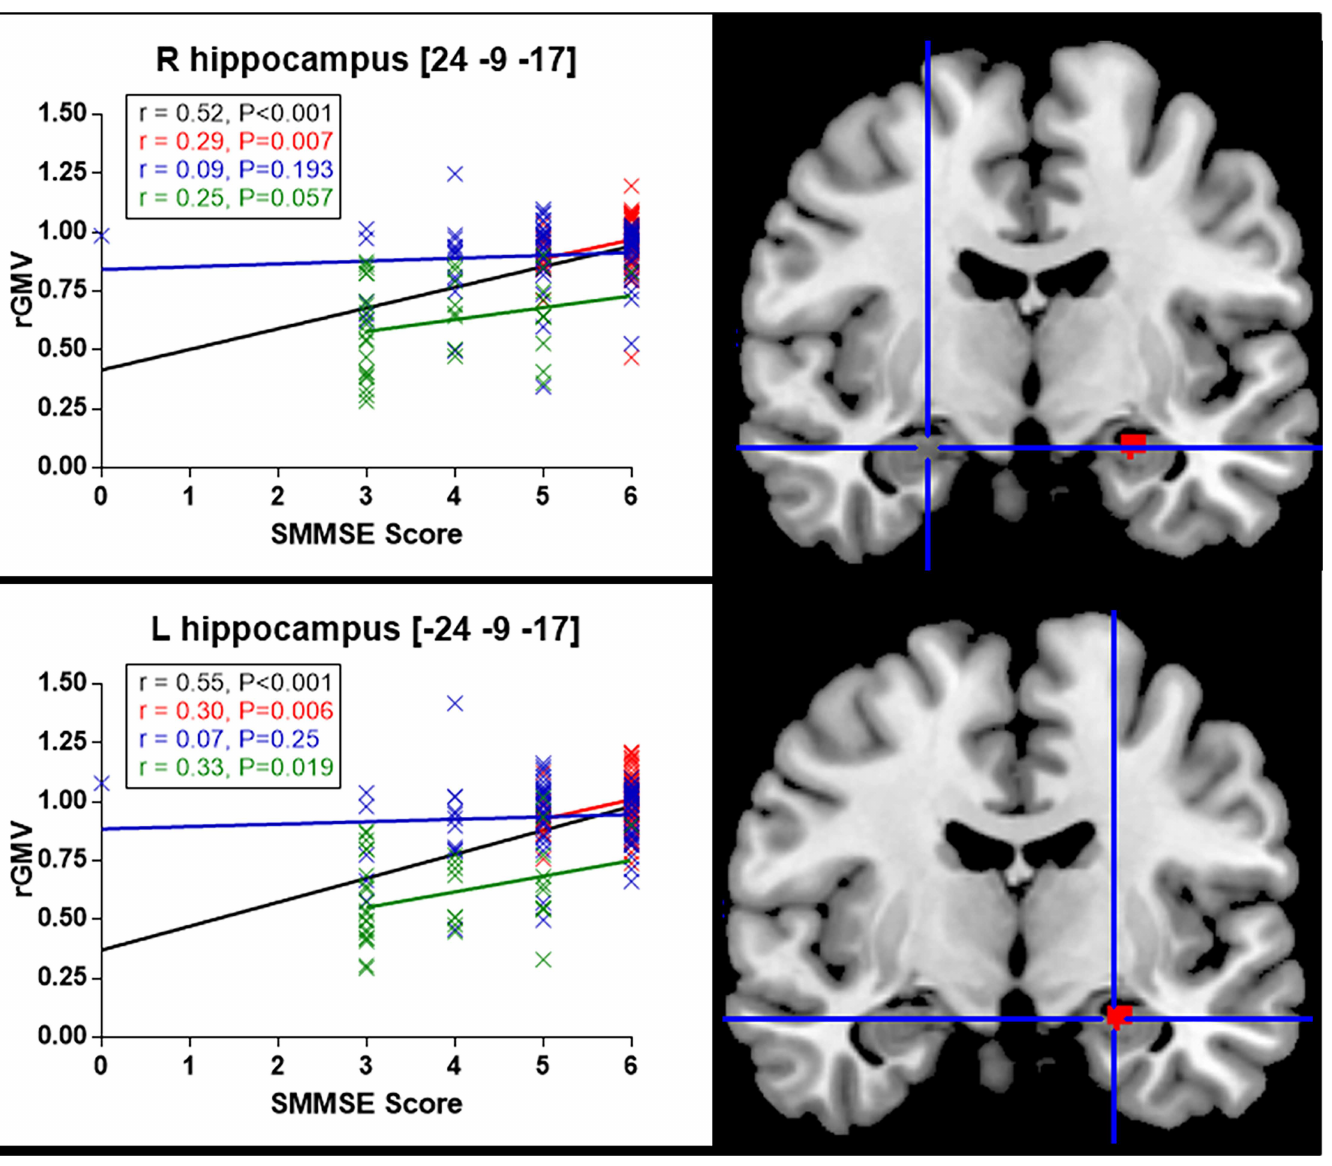
Fig 4. Correlation between the SMMSE score and the regional gray matter volume (rGMV) in right (R) and left (L) hippocampus according to participants’ diagnostic category. Plots points indicate the quantification of the VBM signal sampled from the voxels of the right and left hippocampus. In black: whole sample of participants; red: cognitively healthy participants; blue: participants with MCI; green: participants with AD. L, left in [x y z], MNI coordinates. Results are shown for P < 0.05 corrected for multiple comparisons FWE